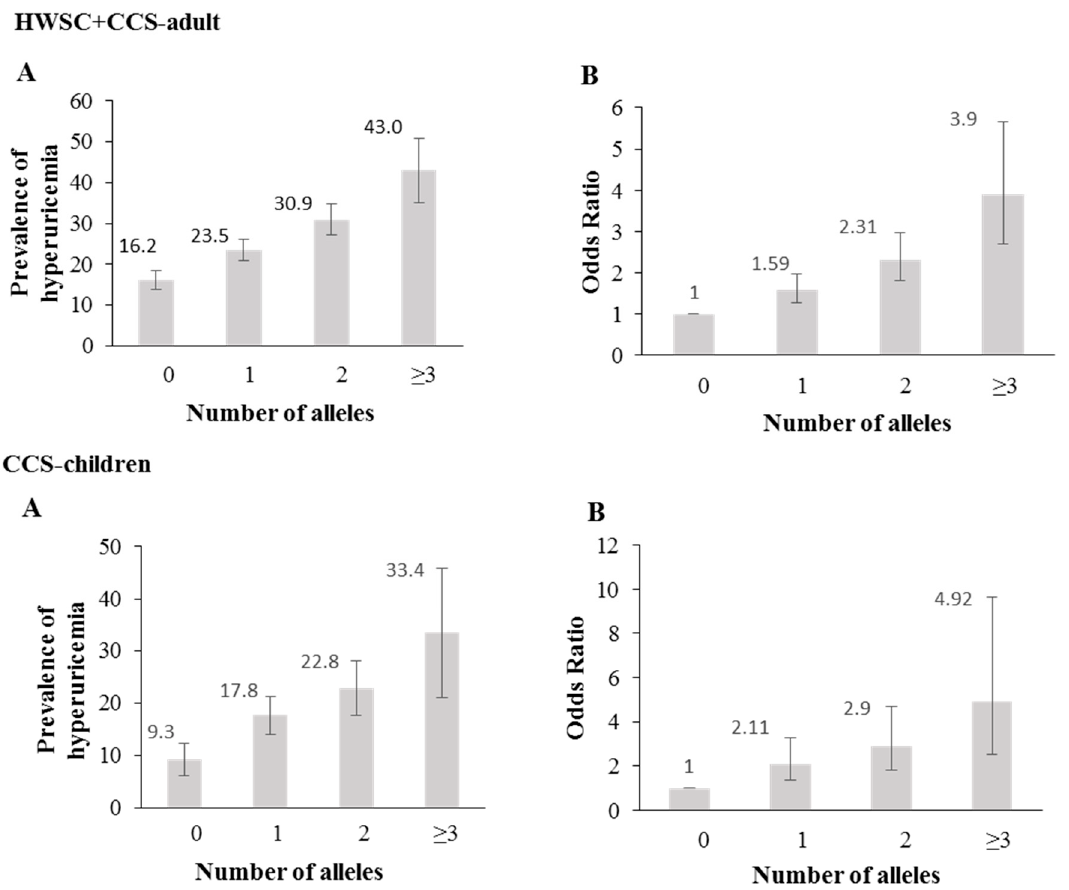
Figure 2. Association between a genetic risk score (GRS) and hyperuricemia. ( A ) Prevalence of hyperuricemia across the genetic risk score (rs11722228 + rs2231142) ( B ) Odds ratio of hyperuricemia